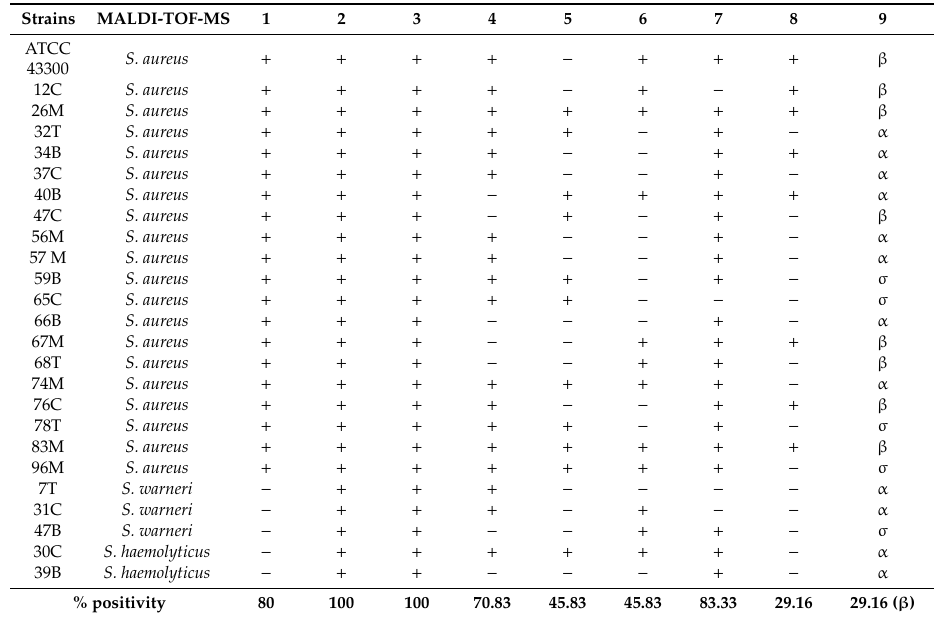
Table 2. Hydrolytic enzymes production and MALDI-TOF identification.